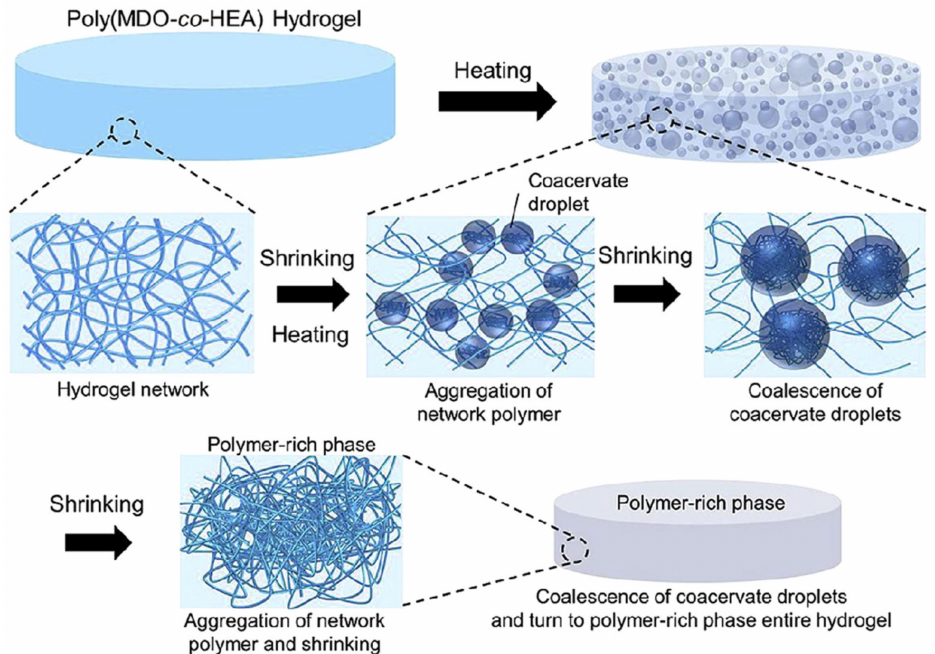
Figure 4. Hydrogel crosslinking on the molecular level, displaying change from raw material and solution to finished crosslinked hydrogel product that can be later used for several different biomedical applications [77]. Adapted with permission from Elsevier,